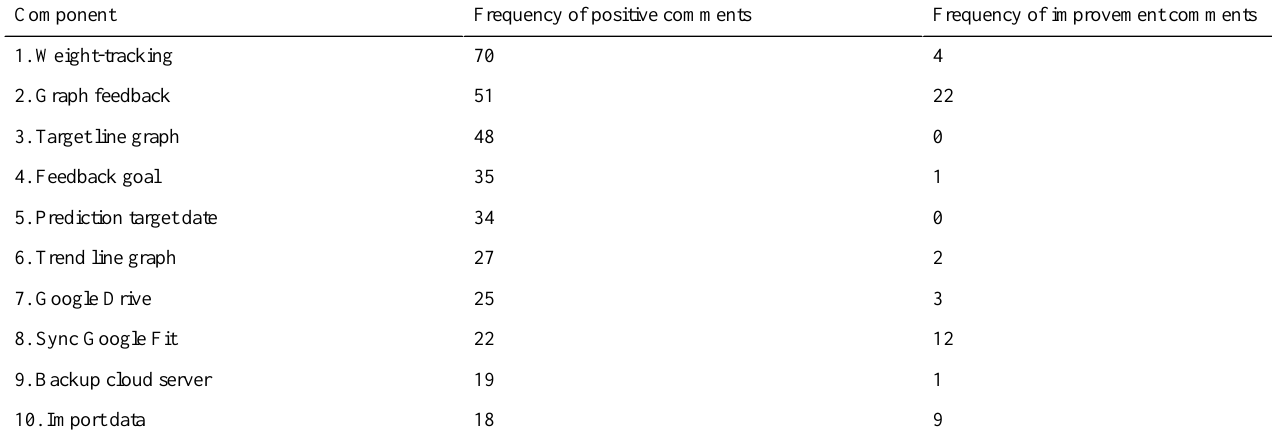
Table 5. The top 10 most positively commented on components. Improvement comments refer to comments where users suggested or demanded the improvement of a specific aspect of the app.